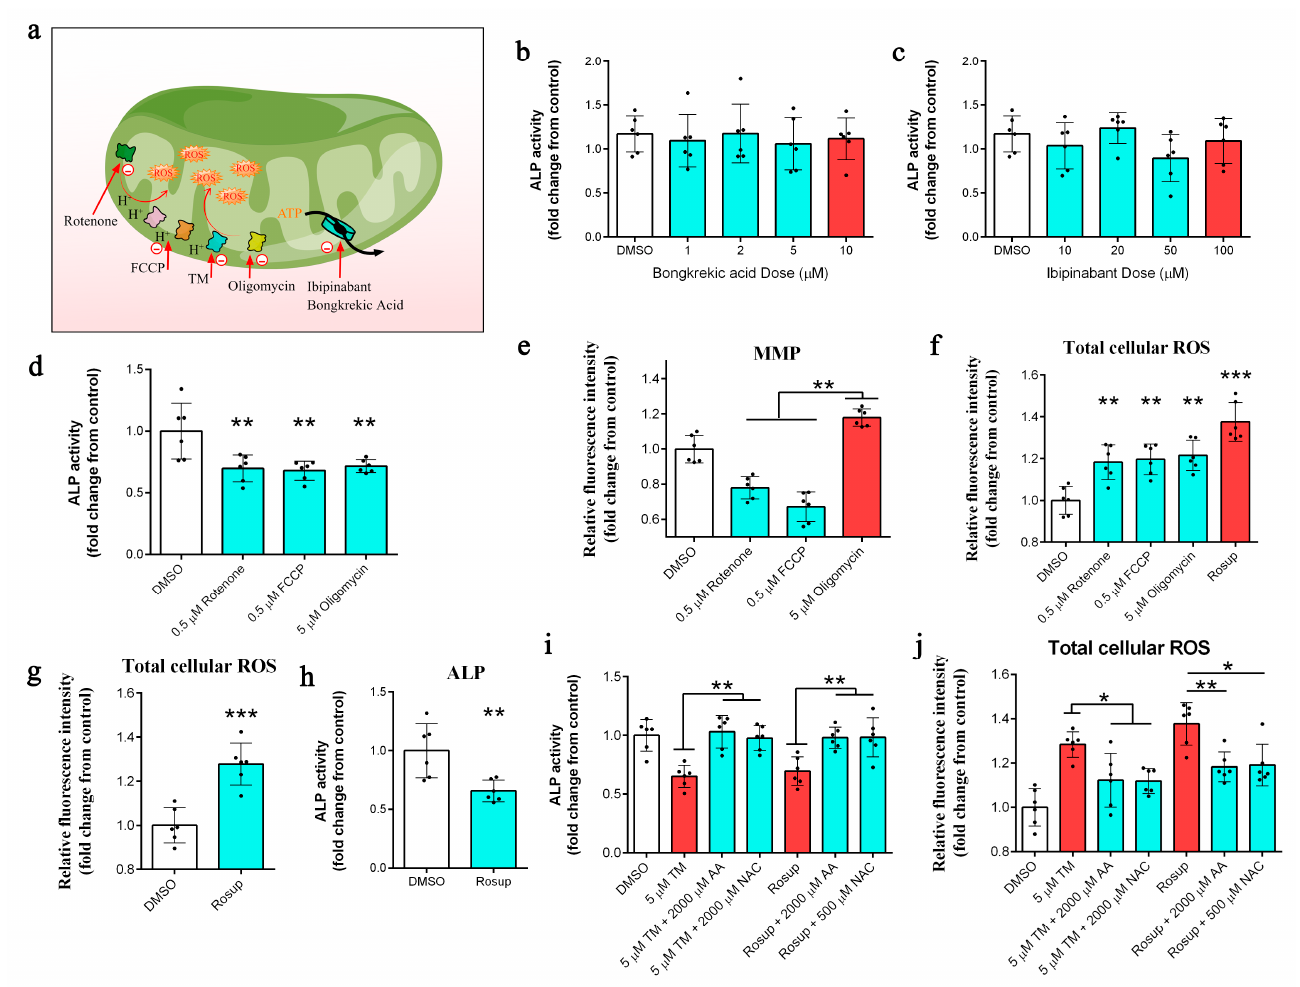
Figure 5. ( a ) Diagram depicting the targets of various mitochondrial perturbagens. ( b , c ) Measurement of ALP activity in DPCs after 24 h of treatments with bongkrekic acid and ibipinabant ( n = 6/group). ( d ) Measurement of ALP activity in DPCs after 24 h of treatments with rotenone, FCCP, and oligomycin ( n = 6/group); ** p < 0.01. ( e ) Measurement of mitochondrial membrane potential (MMP) in DPCs after 24 h of treatments with rotenone, FCCP, and oligomycin ( n = 6/group); ** p < 0.01. ( f ) Measurement of total cellular ROS levels in DPCs after 24 h of treatments with rotenone, FCCP, and oligomycin ( n = 6/group); ** p < 0.01, *** p < 0.001. ( g ) Measurement of total cellular ROS levels in DPCs after 24 h of treatments with Rosup ( n = 6/group); *** p < 0.001. ( h ) Measurement of ALP activity in DPCs after 24 h of treatments with Rosup ( n = 6/group); ** p < 0.01. ( i ) Measurement of ALP activity in DPCs after 48 h of treatments with TM, Rosup, AA, and NAC ( n = 6/group); ** p < 0.01. ( j ) Measurement of total cellular ROS levels in DPCs after 48 h of treatments with TM, Rosup, AA, and NAC ( n = 6/group); * p < 0.05, ** p <